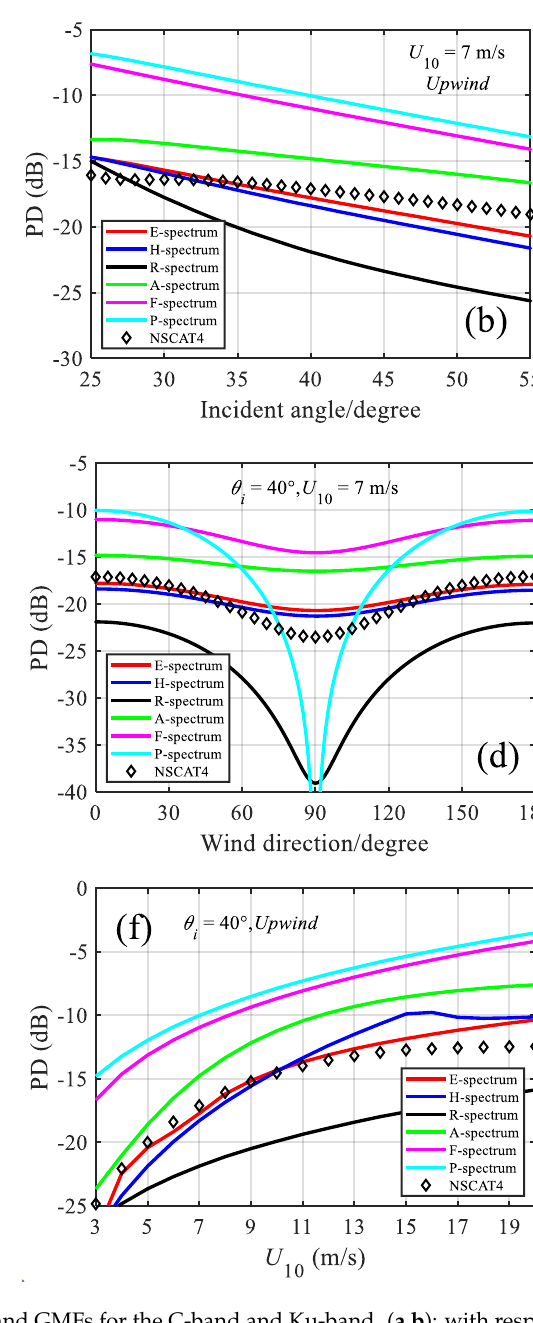
Figure 1. Comparisons of the PD simulated by using the TSM and GMFs for the C-band and Ku-band. ( a , b ): with respect to incidence angles, ( c , d ): with respect to wind speeds; ( e , f ): with respect to wind directions.